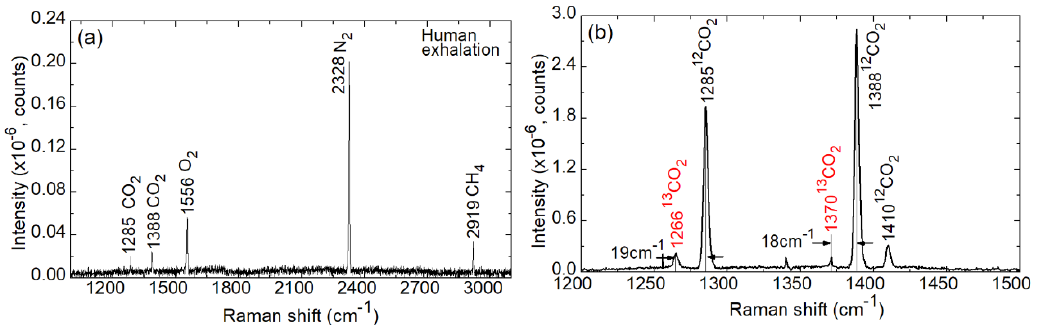
Figure 7. Raman spectrum of the human breath (exhalation): ( a ) an overview spectrum; ( b ) a close view of the 12 CO 2 / 13 CO 2 lines. The excitation wavelength λ exc = 532.123 nm, the resolution is ~1 cm −1 . Gas pressure: 1 atm. Exposure time: ( a ) 30 s, ( b ) 600 s.